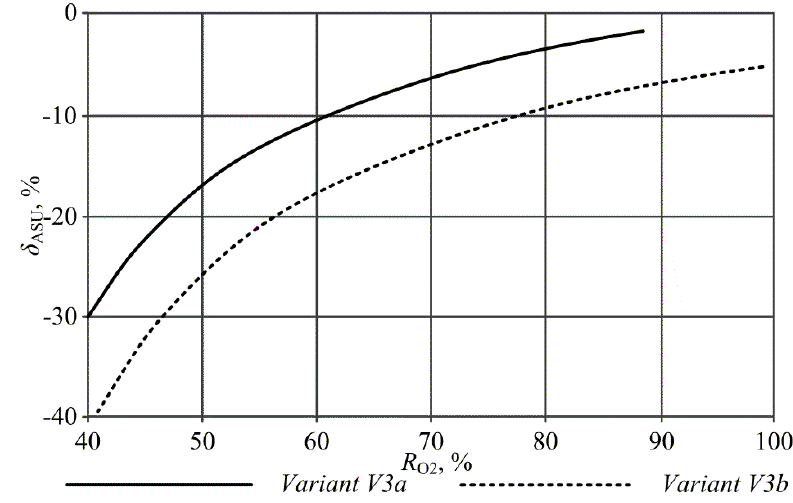
Figure 13. The ASU’s auxiliary power rate as a function of the oxygen recovery rate.